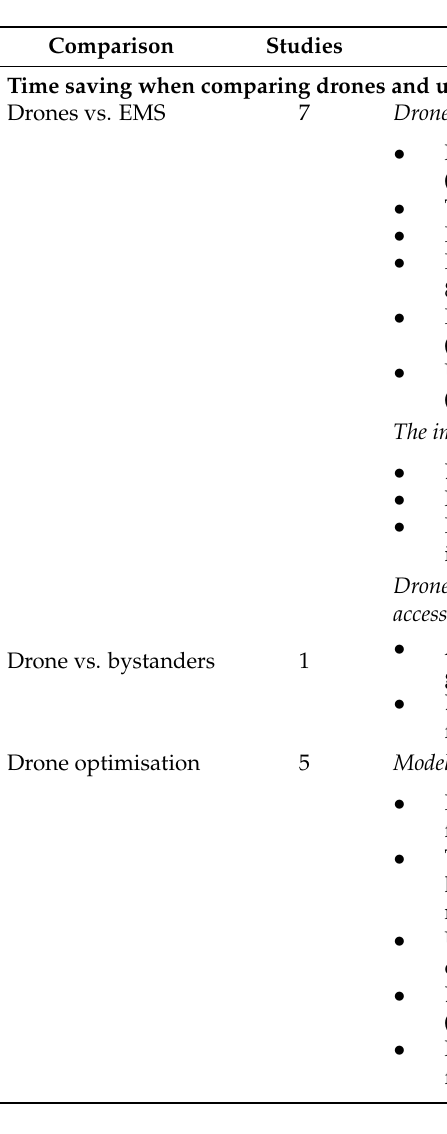
Table 2. Summary of Results from Simulation and Interventional